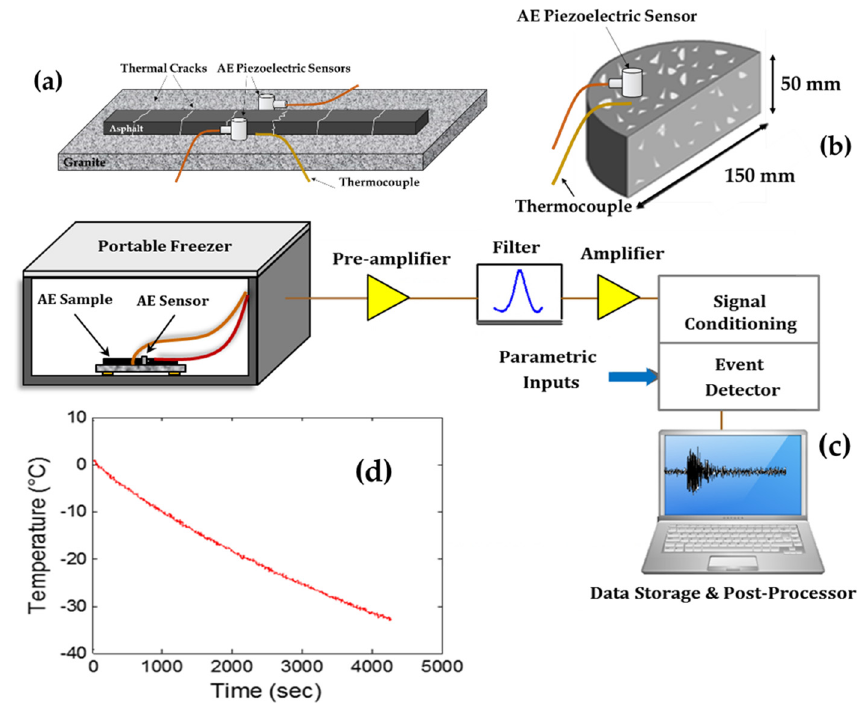
Figure 5. AE testing of asphalt materials; ( a ) asphalt binder test sample after AE testing showing two AE sensors and one thermocouple; ( b ) test sample for asphalt concrete mixtures; ( c ) AE test system for evaluating binders and asphalt concrete mixtures test samples; ( d ) typical temperature vs. time cooling plot for asphalt concrete mixture test samples.